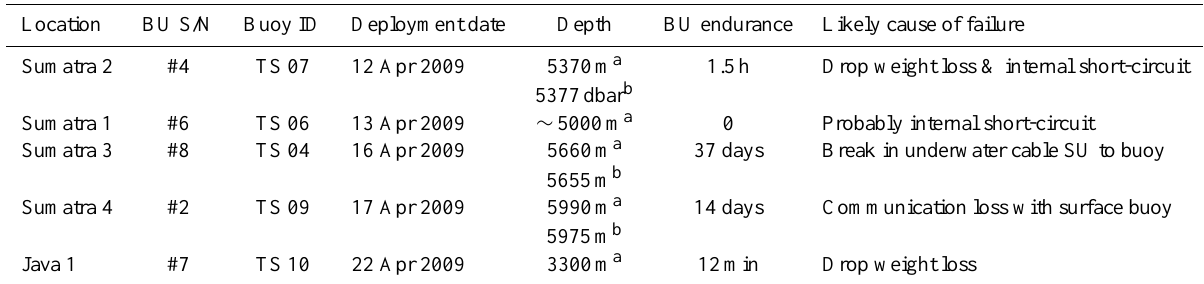
Table 2. Summary locations, associated equipment, and confirmed system endurance. a Data from ship’s echosounder. b Data on basis of PACT-BU pressure